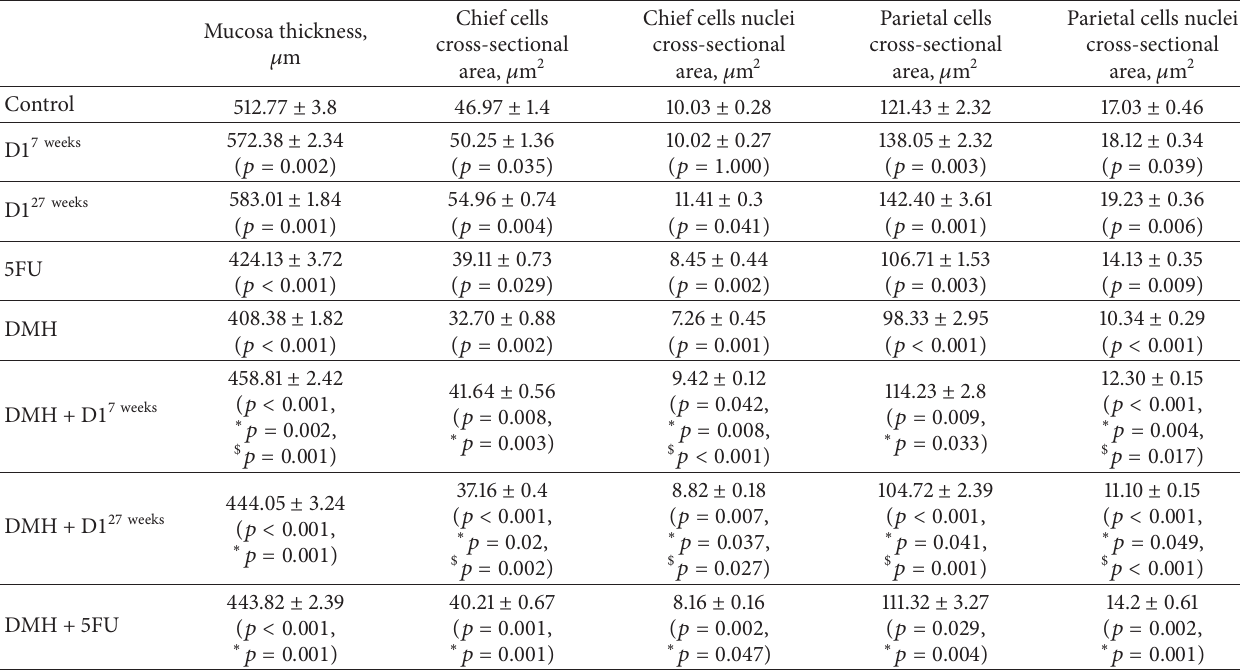
Table 3: Morphometric parameters of gastric mucosa for rats treated by D1 and 5FU under DMH-induced carcinogenesis. Mean ± SEM, 𝑛 = 10 # . Mucosa thickness, 𝜇 m